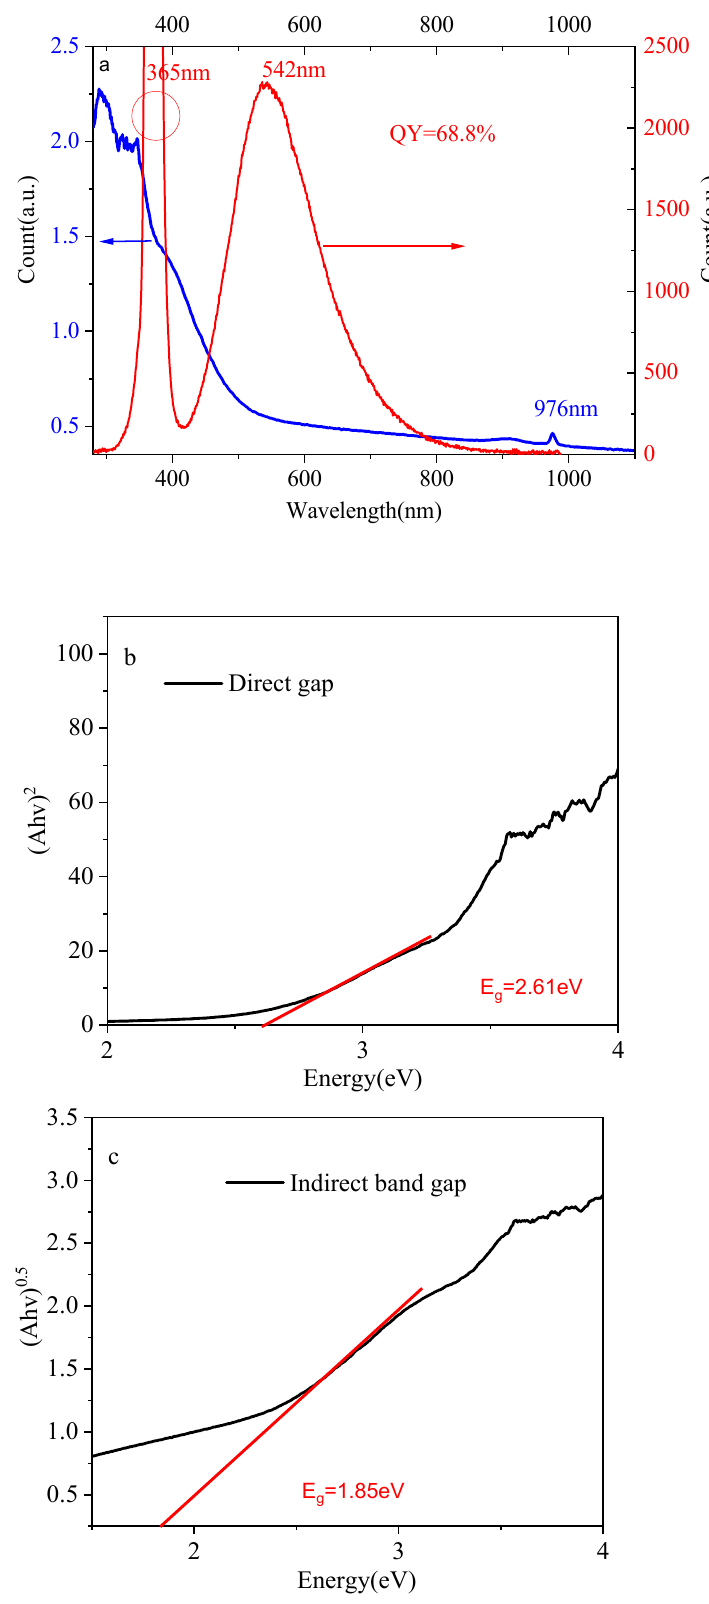
Figure 2. ( a ) UV–near-infrared absorption and photoluminescence spectra with 365 nm excitation; ( b ) direct optical band gap energy spectrum; ( c ) indirect optical band gap energy spectrum.